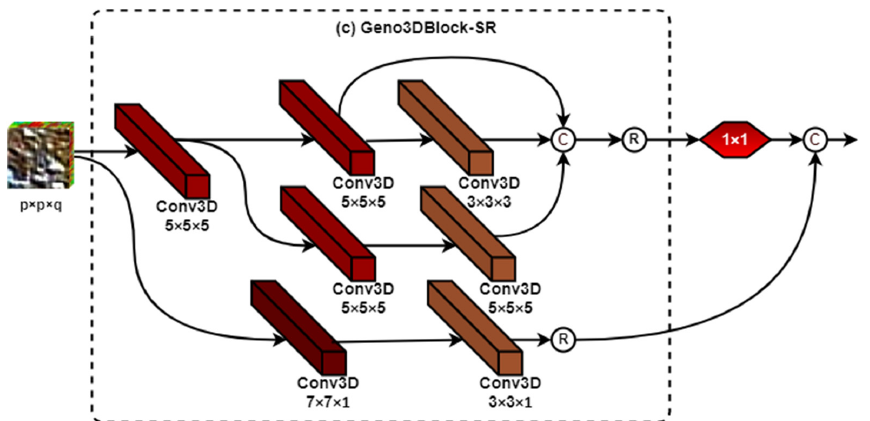
Figure 6. Framework of Geno3Dblock-SR.